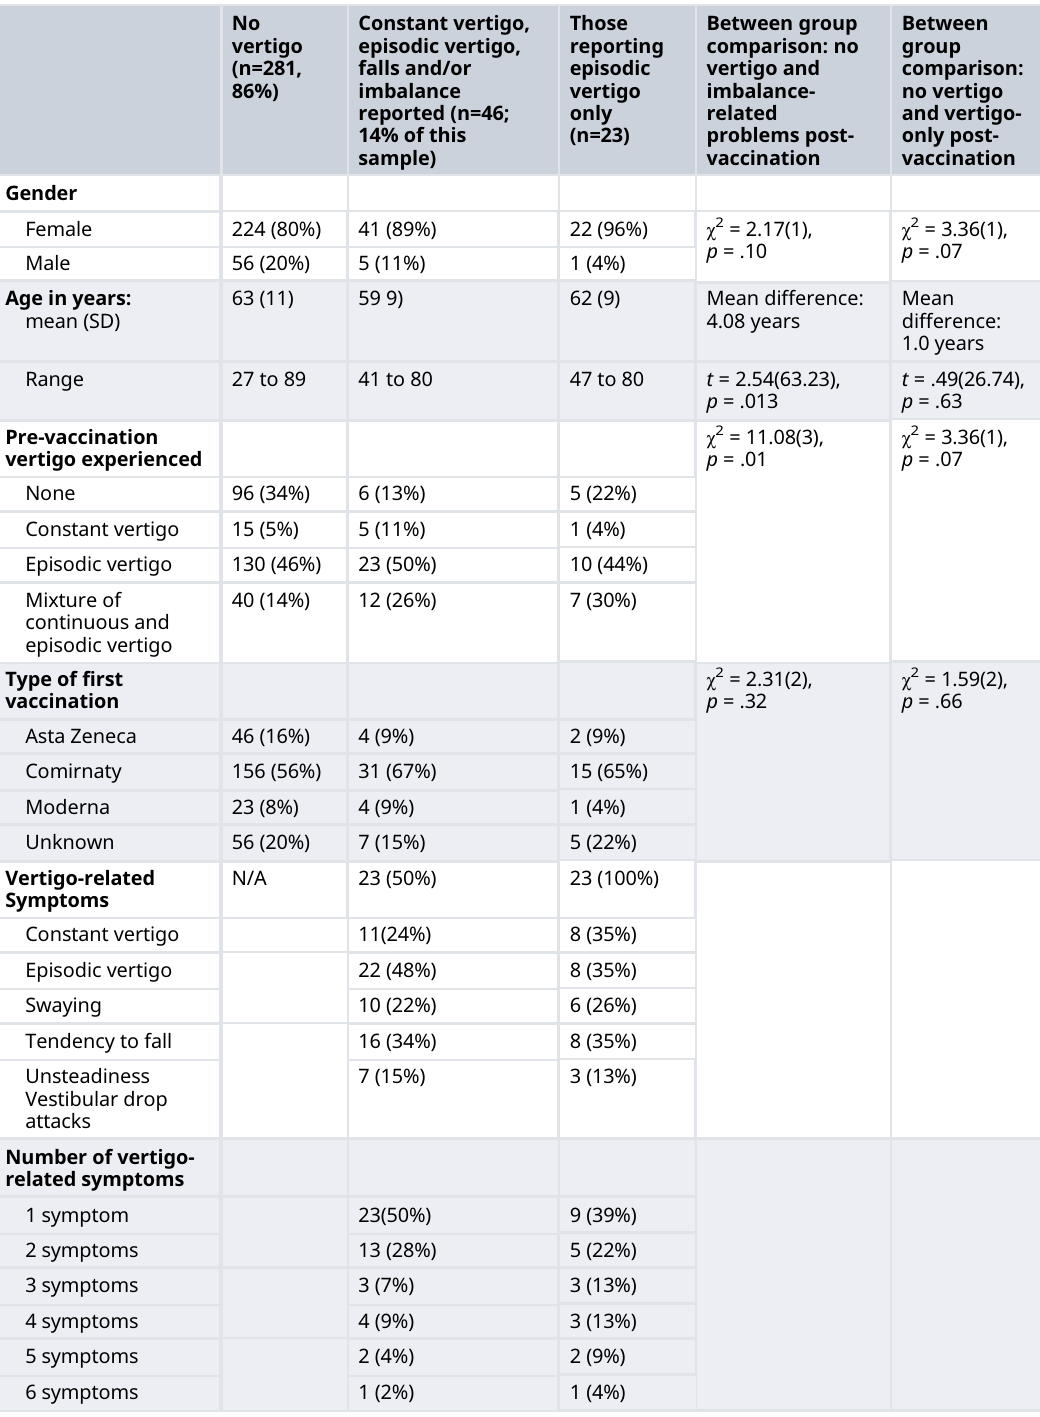
No Constant vertigo, vertigo episodic vertigo, (n=281, falls and/or 86%) imbalance reported (n=46; 14% of this sample)